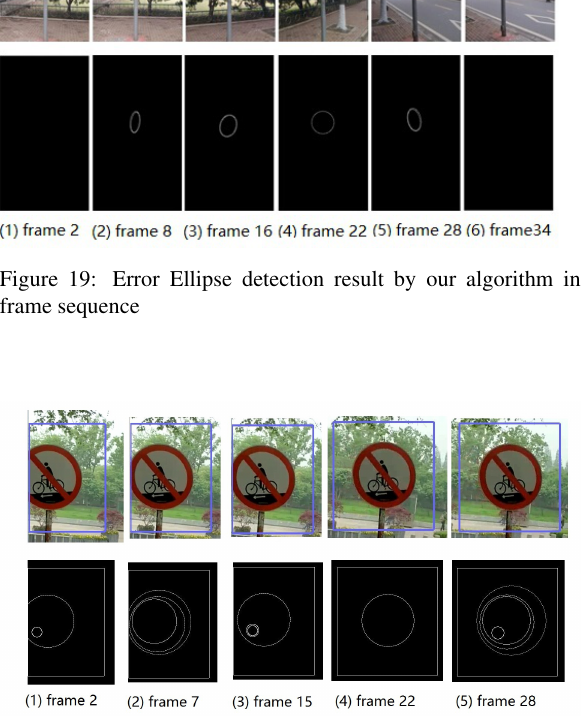
Figure 20: Error Ellipse detection result by our algorithm in an- other frame sequence